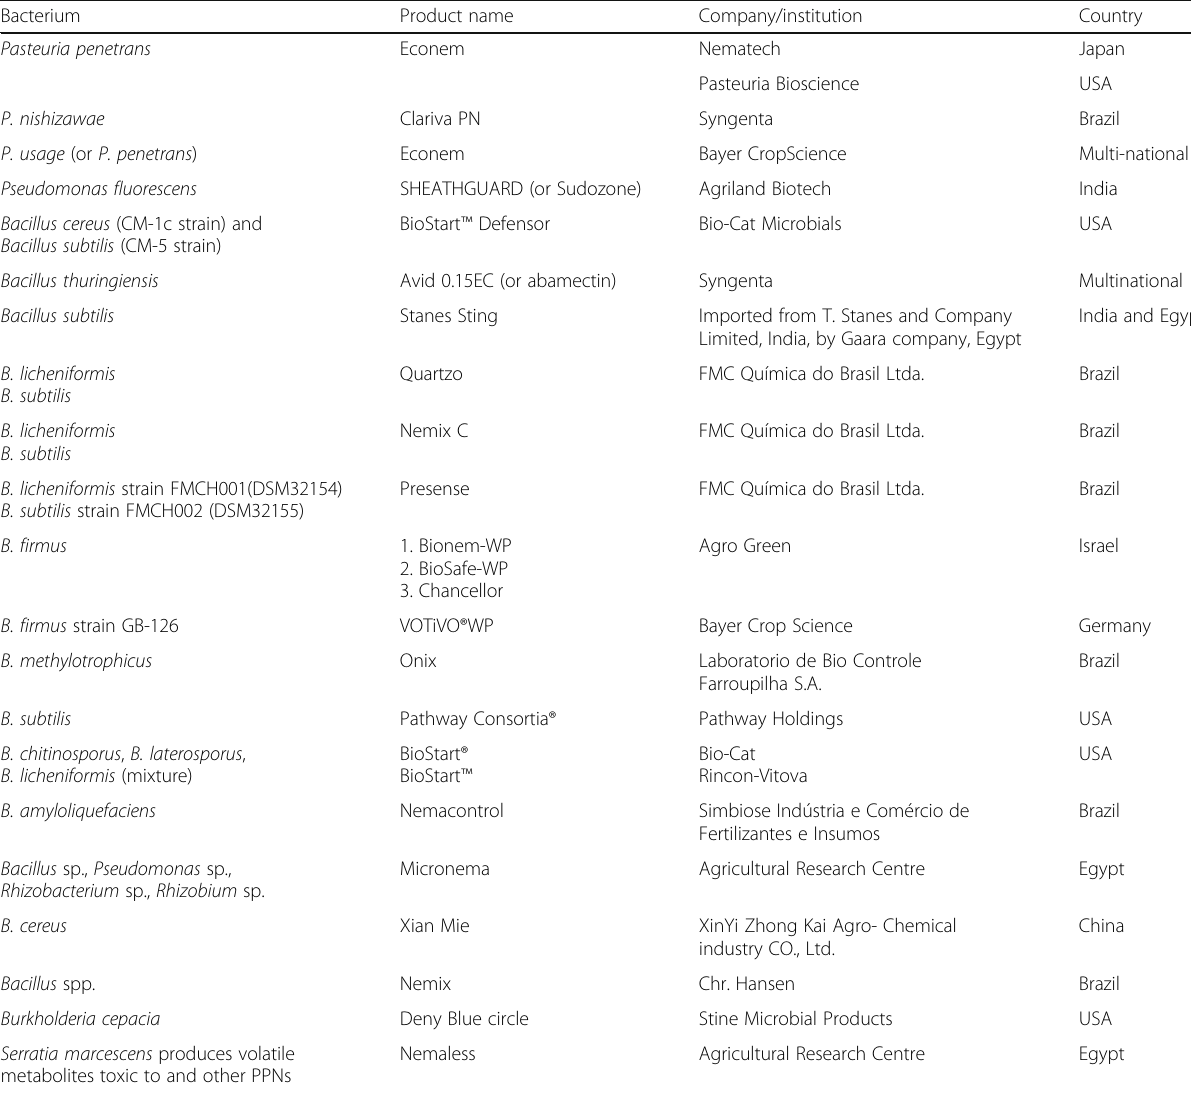
Table 5 List of commercial products of bacterial biocontrol agents used in the management of plant-parasitic nematodes